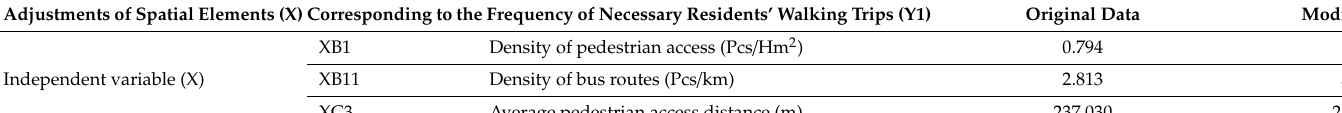
Table 11. Adjustment of spatial